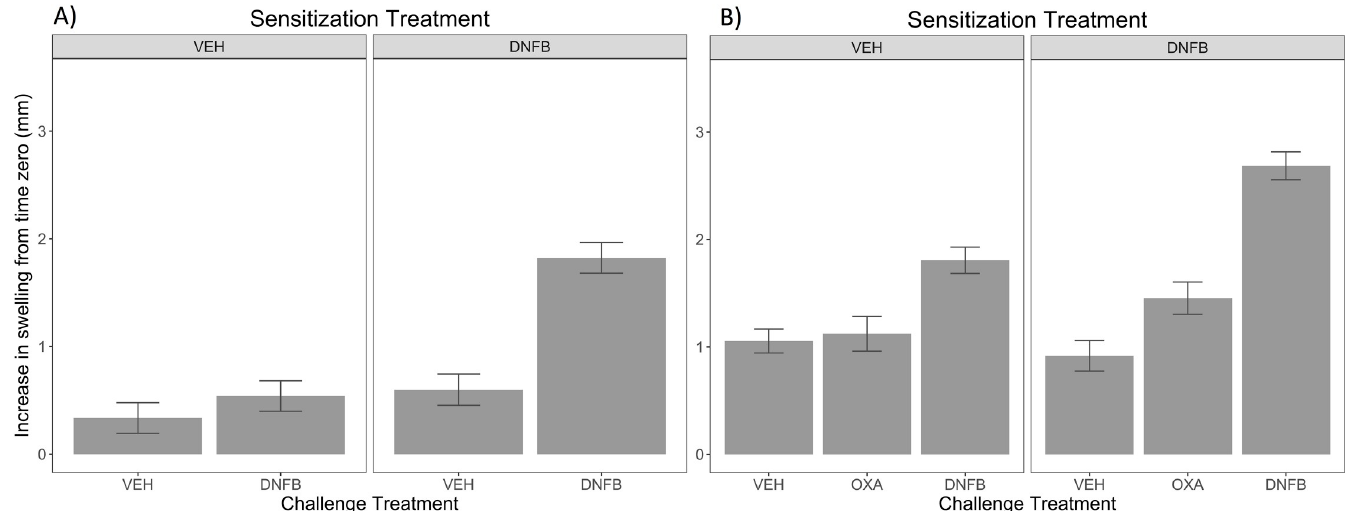
Fig 3. Improved protocol ear thickness shows hapten-specific ear inflammation response in ears of normal pigs as early as 7 days post-sensitization. 15–30 kg pigs had DNFB or 4:1 acetone:olive oil vehicle applied dropwise to their backs. Animals were challenged after 21 or 7 days with intradermal ear injections of DNFB, OXA, or respective vehicle. Shown here is the LS means of ear thickness difference (mm) from time zero to 48 hours for sensitization periods of (A) 21 days or (B) 7 days. The interaction of back sensitization � ear treatments was evaluated for significance of hapten-specific memory. With a threshold p-value < 0.05, 21 day (p-value < 0.01) and 7 day (p-value < 0.01) sensitization periods showed evidence of hapten-specific ear swelling. Error bars represent standard error.